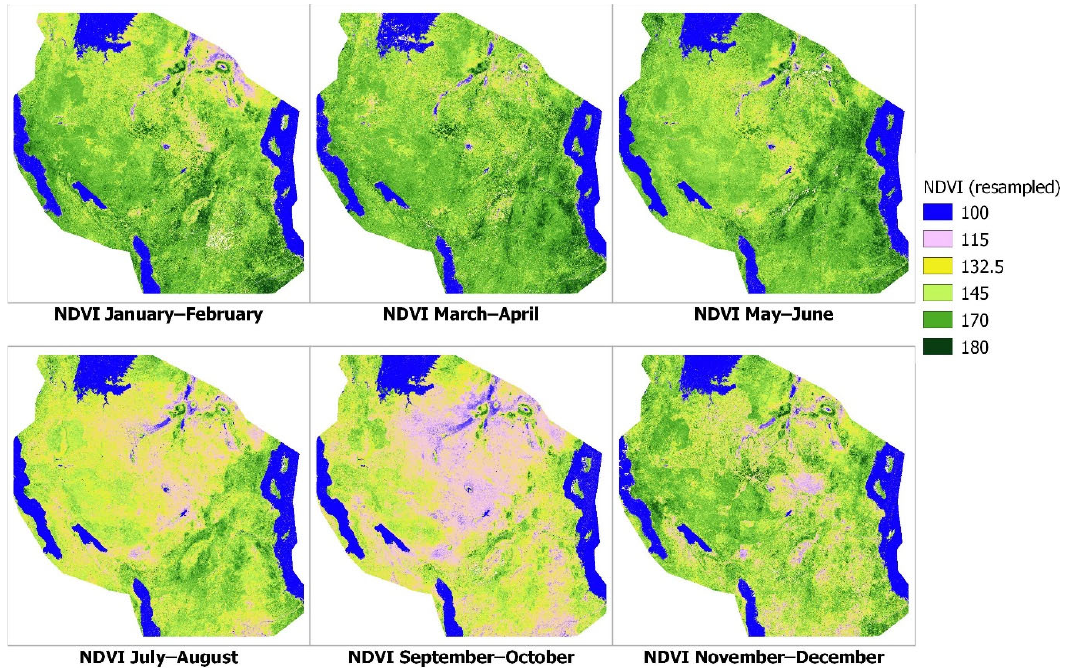
Figure 8. NDVI bi-monthly composites for 2018. The NDVI values from − 1 to 1 are rescaled to Figure 8. NDVI bi ‐ monthly composites for 2018. The NDVI values from − 1 to 1 are rescaled to 0– 200.